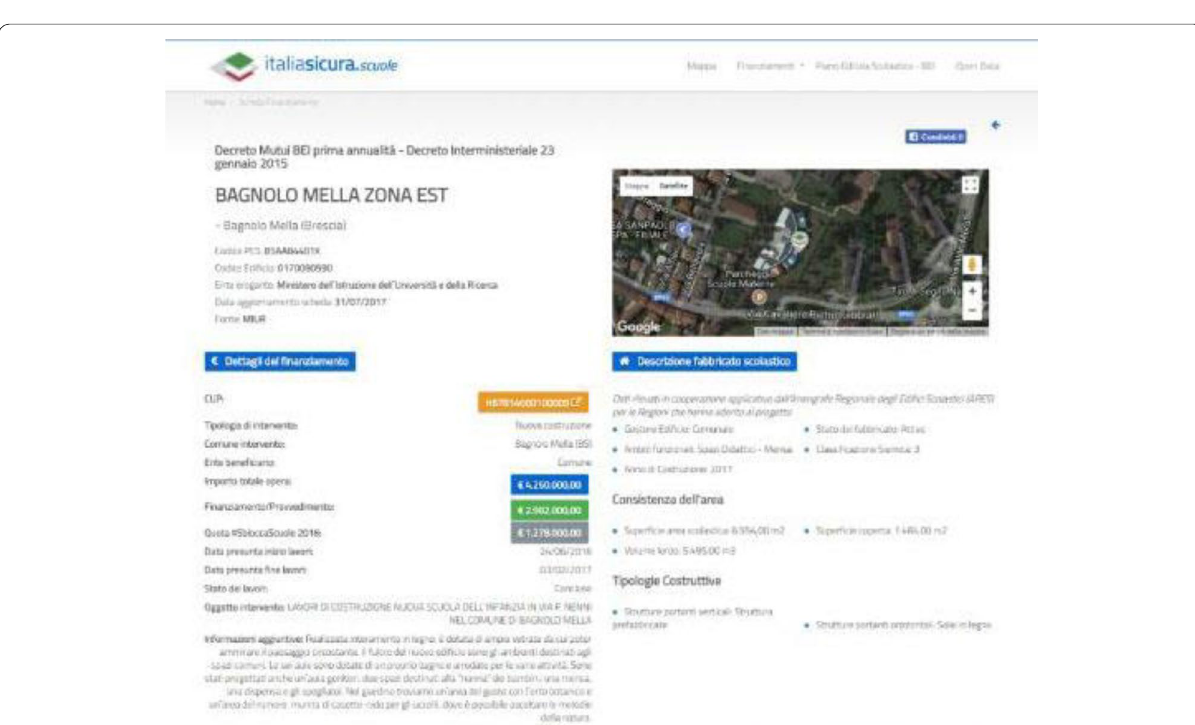
Fig. 4 Form for single project. (Source: Governo. ItaliaSicura Scuole. http://www.canti erisc uole.it Accessed 10 January 2018, the site has not been updated since the SMES closure, since January 2019 no longer available